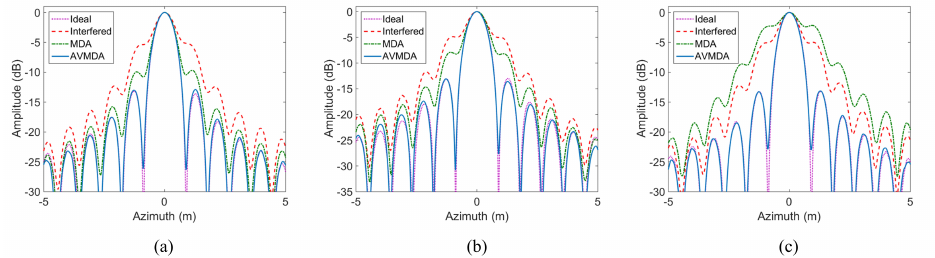
Figure 7. Azimuth impulse response curve comparison of Point A, B, and C. ( a ) Point A. ( b ) Point B. ( c ) Point